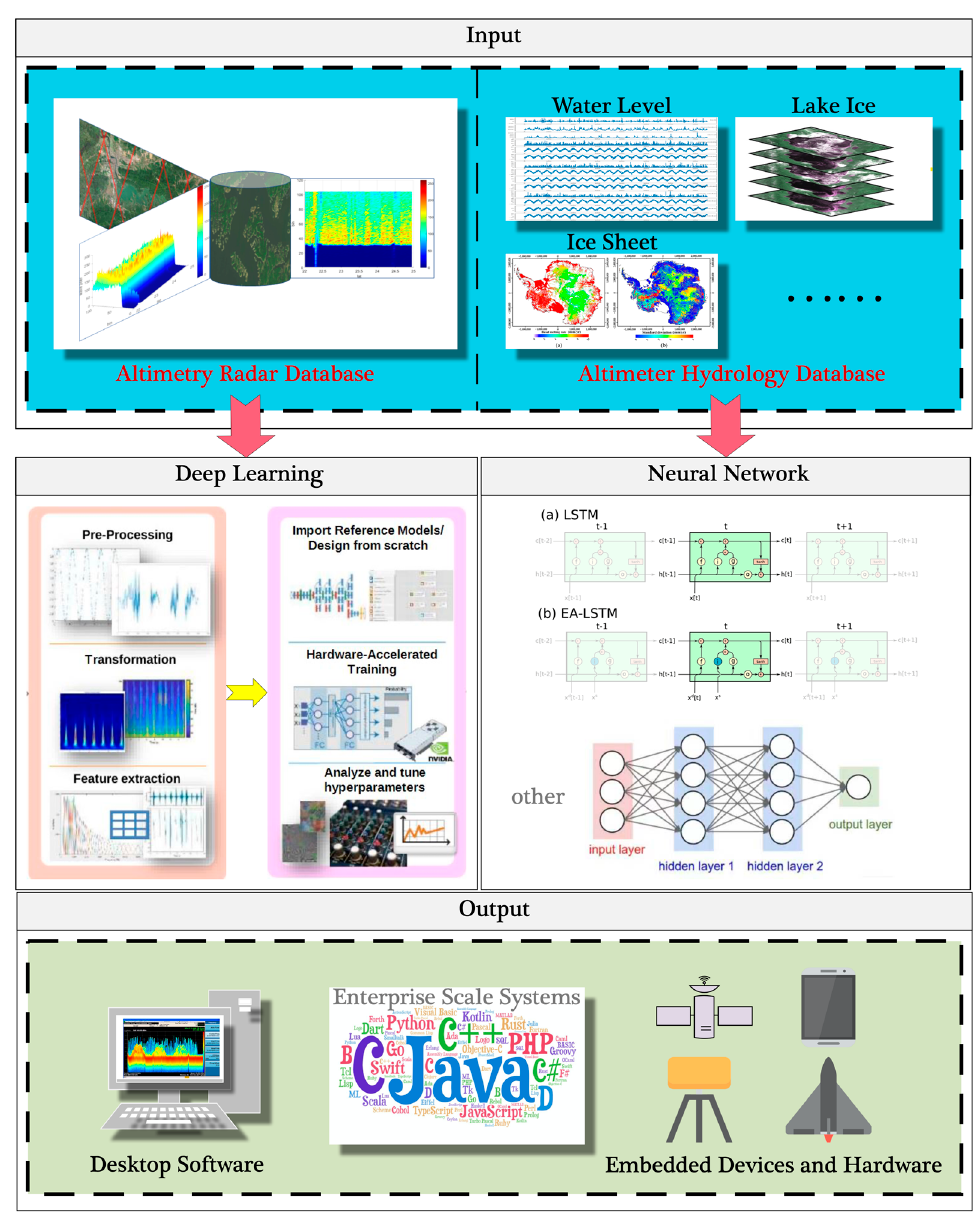
Figure 5. Schematic diagram of the fusion strategy of satellite altimetry and AI.